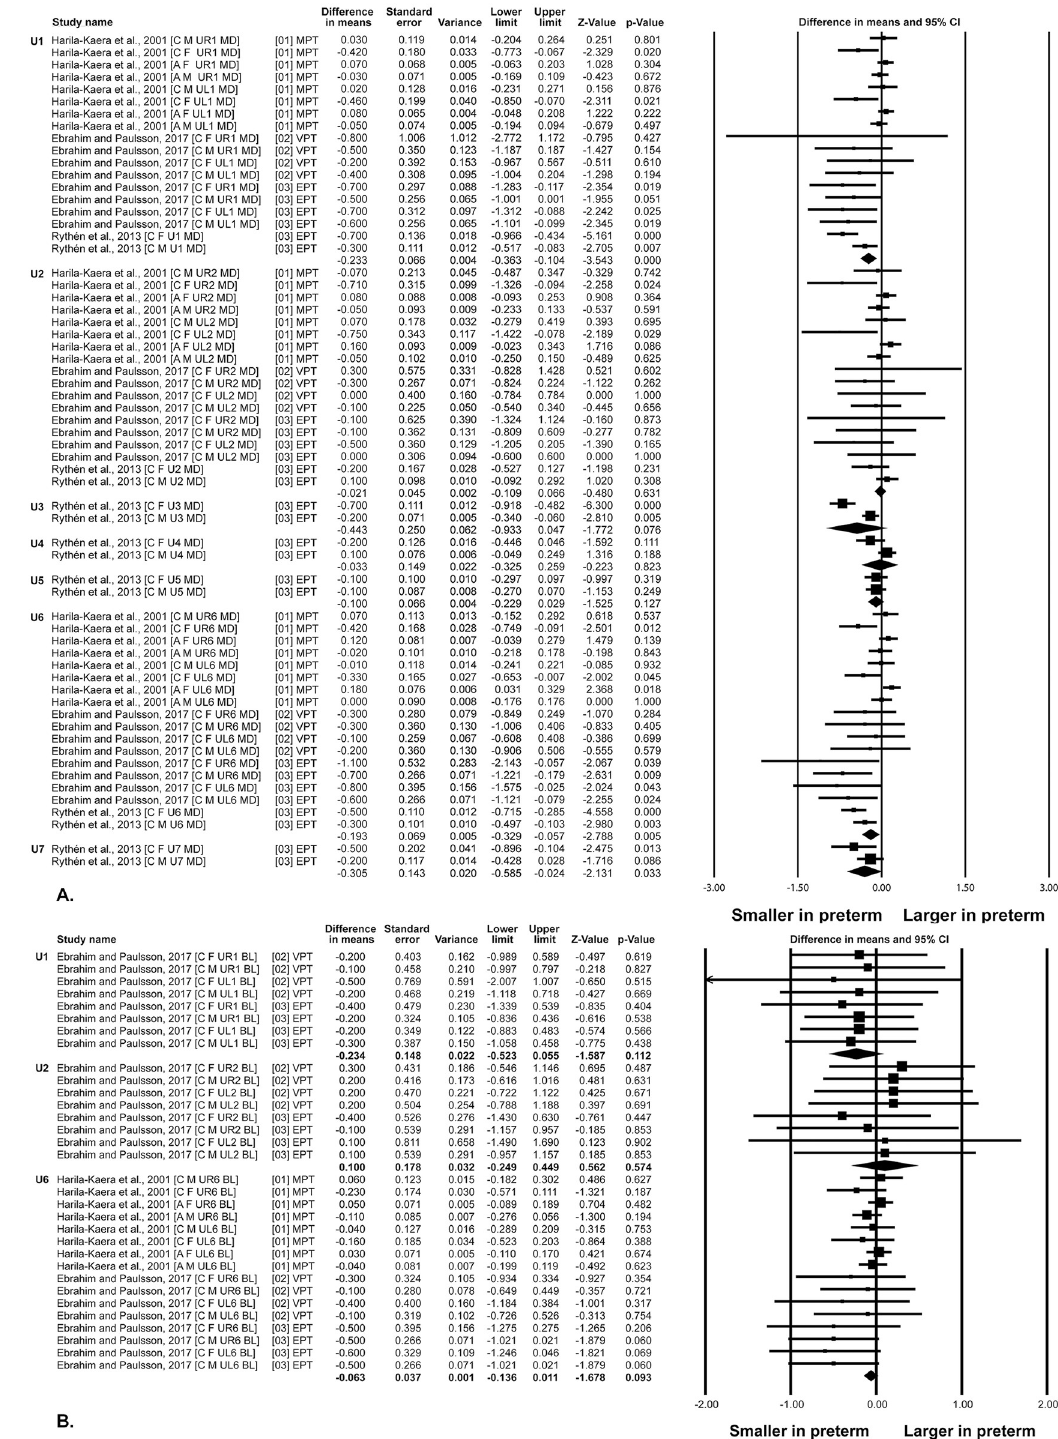
Fig 3. Differences in teeth dimension between preterm and control children. Maxillary teeth. A. Mesiodistal dimensions. B. Buccolingual dimensions. A: African American; BL: Buccolingual; C: Caucausian; CI: Confidence Interval; EPT; Extremely preterm; F: Females; M: Males; MD: Mesiodistal; MPT: Moderate preterm; UL: Maxillary left teeth; UR: Maxillary right teeth; VPT: Very preterm.